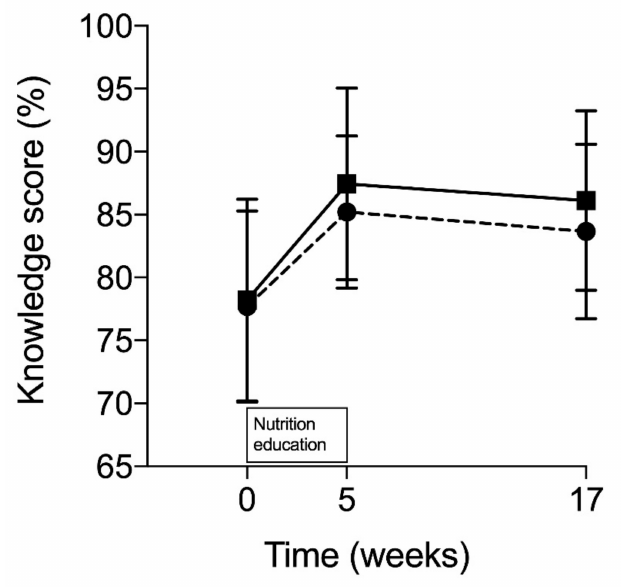
Figure 3. Mean nutrition knowledge scores with SD at baseline, after nutrition education and after follow-up. Black line with squares refers to the EDU + APP group (education sessions + the use of mobile food app) and dotted line with circles to the EDU group (education sessions only). p = 0.309 for group × time interaction, p < 0.001 for main e ff ect of time, and p = 0.309 for main e ff ect of